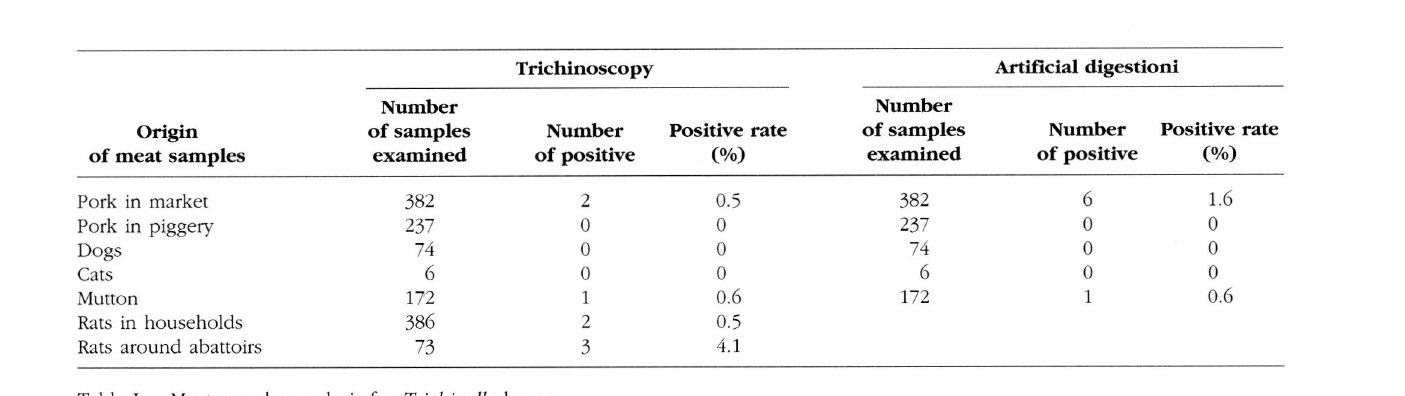
Table I. - Meat samples analysis for Trichinella larvae.